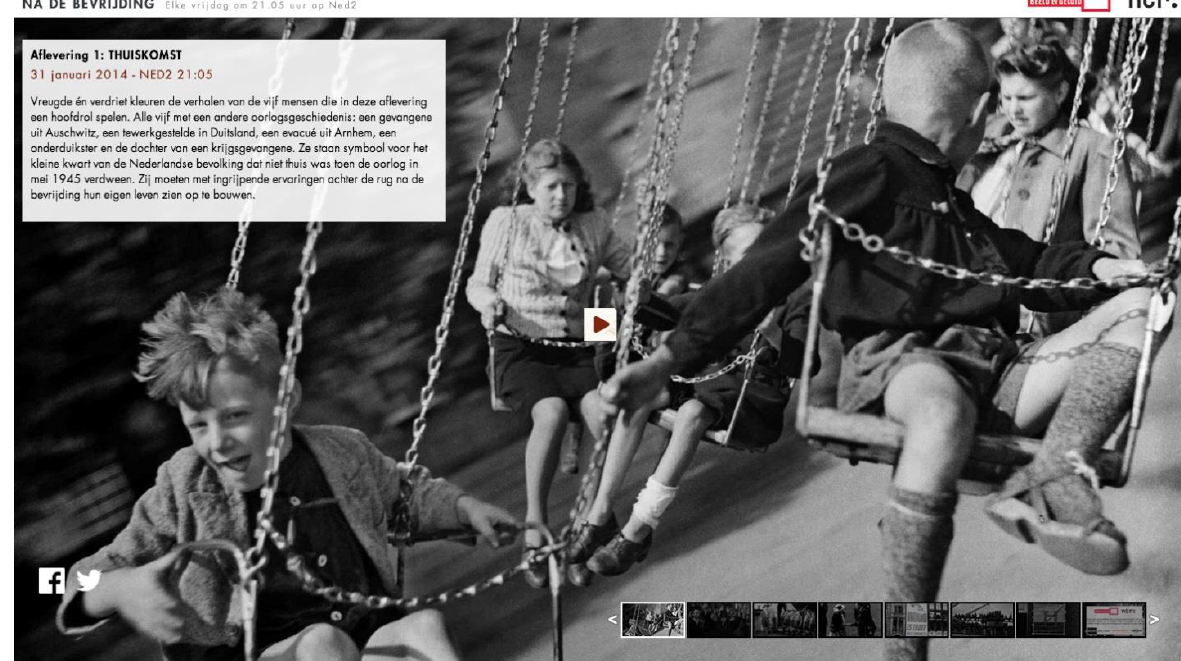
Figure 2. After the Liberation XL website. Source: http://www.nadebevrijding.nl